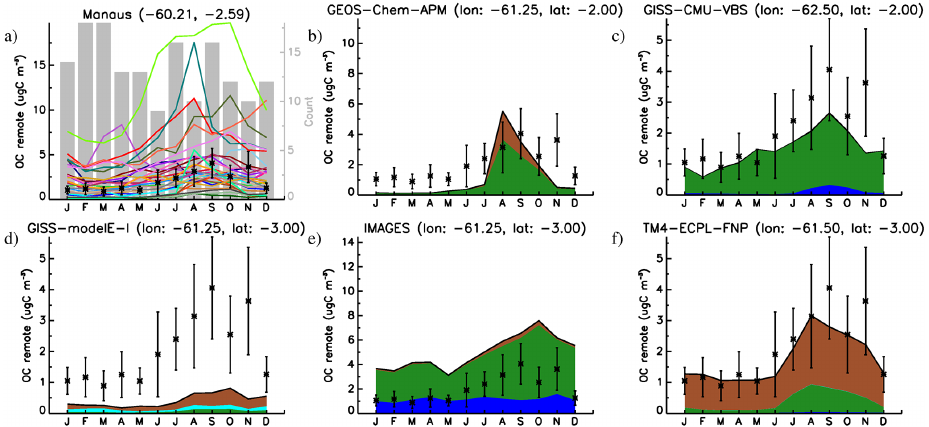
Figure 22. Same as in Fig. 18, for Manaus, Brazil (remote, years 2008–2010). For the chemical composition in (b–f) , brown is tPOC, green is trSOC, cyan is mPOC, blue is ntrSOC, and orange is